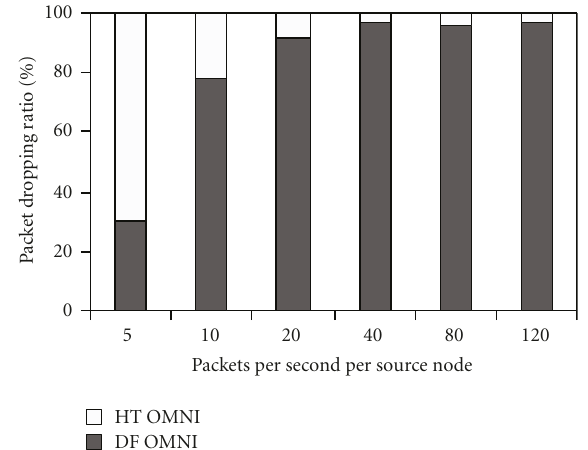
Figure 19: OMNI IEEE 802.11: deafness versus hidden terminals.